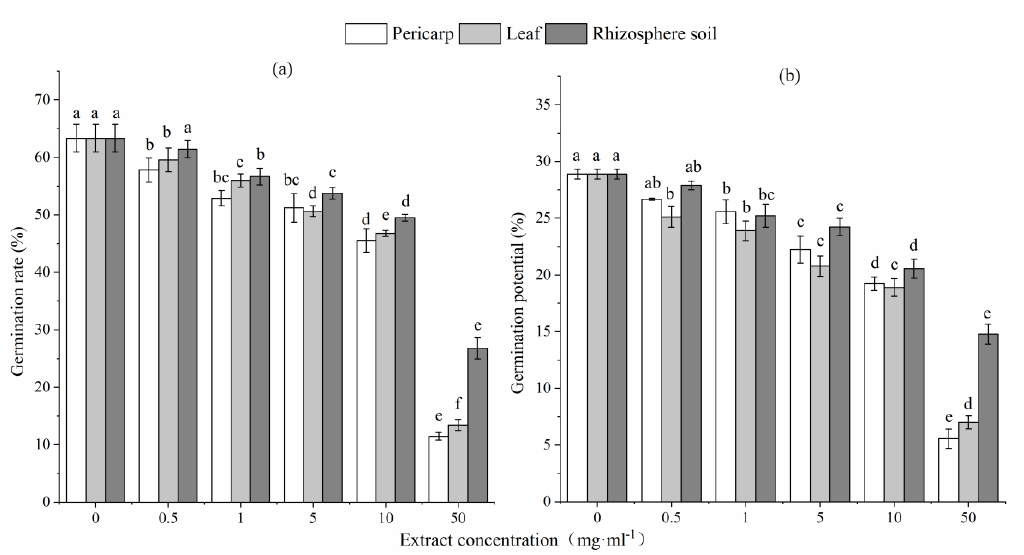
Figure 1. Germination rate ( a ) and potential ( b ) of L. formosana seeds following treatment with different concentrations of C. migao pericarp, leaf, and rhizosphere soil aqueous extracts. Lowercase letters represent significant differences in each treatment group ( p < 0.05).